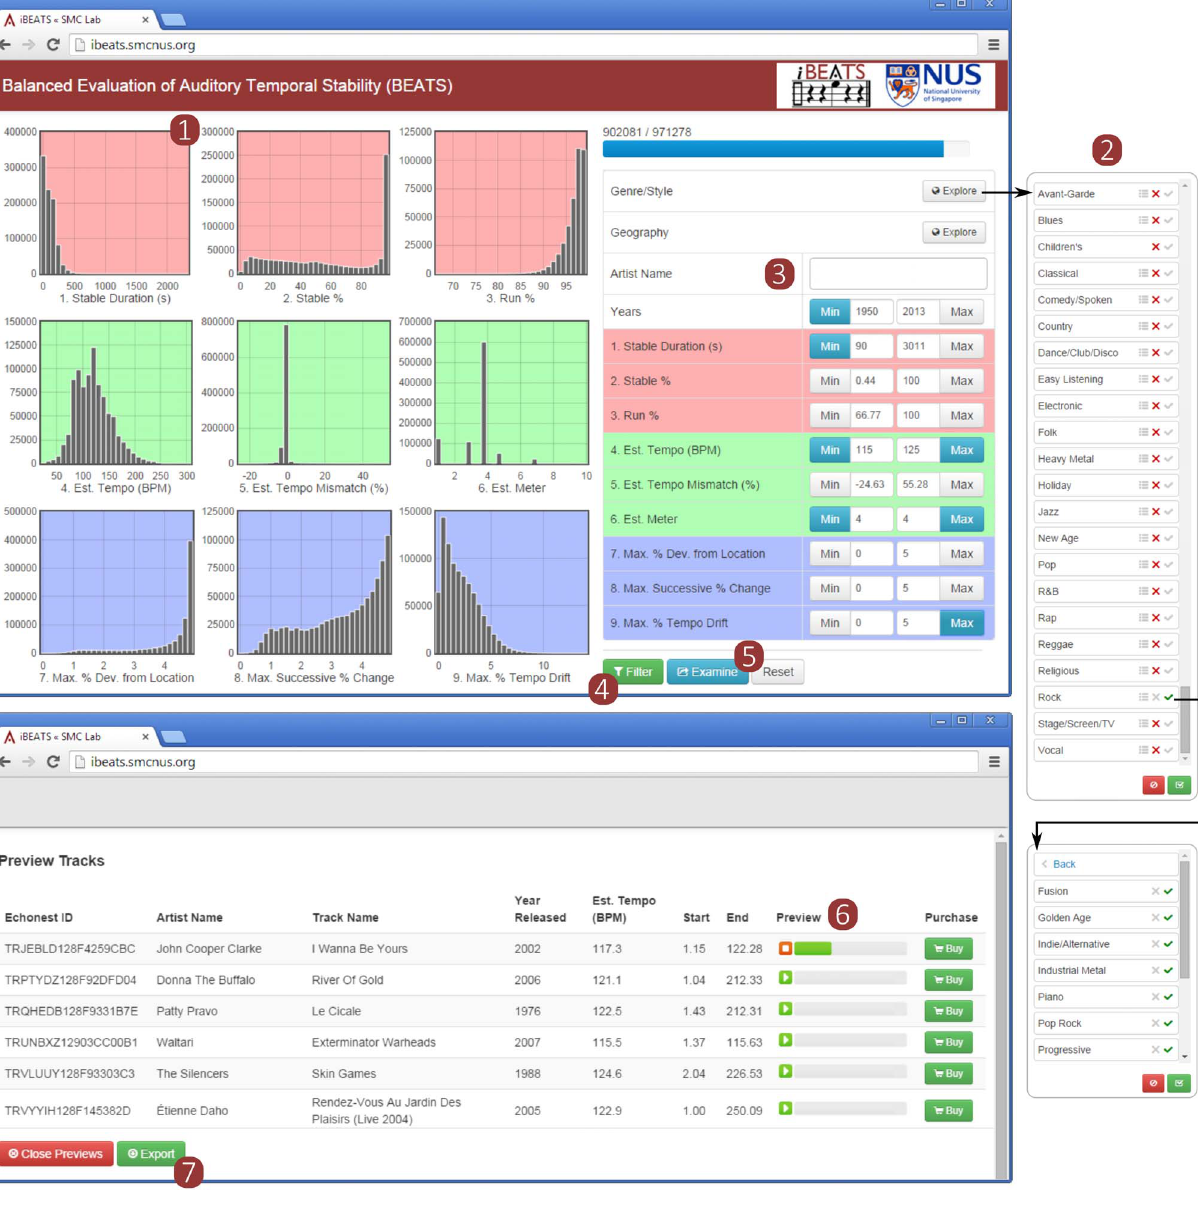
Figure 6. The iBEATS website ( http://ibeats.smcnus.org/ ). The nine Summary Statistics are visualized using histograms (1). The user queries iBEATS by adjusting the numeric thresholds, browsing a two-level hierarchy of Genre/Style and Geography terms (2), and/or direct input to the Artist Name field (3). Filtering (4) reveals the number of candidate songs satisfying the query, which may then be further examined (5) and an audio sample previewed (6). The candidate playlist may then be exported (7) for subsequent use by a streaming music service (e.g., Spotify).